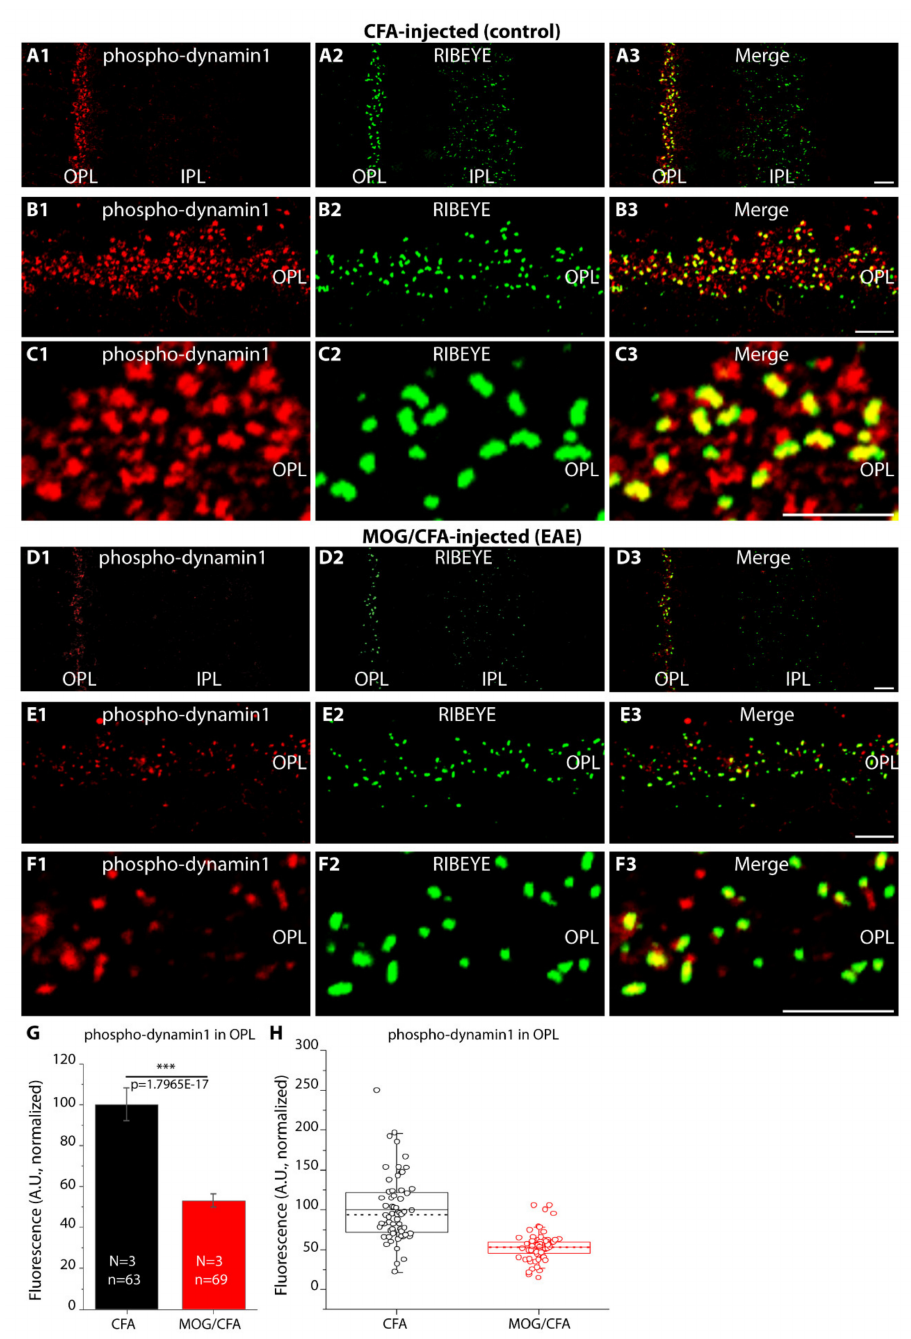
Figure 12. Phospho-dynamin1 immunosignals in photoreceptor synapses of MOG/CFA-injected early EAE mice are reduced in comparison to control mice. ( A1 – F3 ) Retina sections (0.5 µ m thickness) from CFA- and MOG/CFA-injected mice obtained on day 9 after injection were double immunolabelled with phospho-dynamin1 and RIBEYE antibody (clone 2D9), as indicated in the figure. ( C1 – C3 , F1 – F3 ) magnified views of the OPL immuno-labelled with anti-phospho-dynamin1 and anti-RIBEYE. ( G , H ) Quantification of fluorescence intensity (integrated density) of phospho-dynamin1 immunosignals in the OPL of MOG/CFA-injected and CFA-injected control mice. Values in ( G ) are means ± S.E.M. In the box-and-whiskers plots ( H ) of the data from ( G ), mean values are indicated by solid horizontal lines; median values by dotted horizontal lines. Boxes represent the 25th–75th percentiles of data points and whiskers are equal to 1.5 times of the interquartile range (IQR). Mann–Whitney U-test was applied to determine the statistical significance for fluorescence intensity in ( G , H ). ( C1 – C3 , F1 – F3 ) High magnification confocal images of the immunolabelled OPL indicate enrichment of phospho-dynamin1 at the ribbons but also expression of phospho-dynamin1 in some distance from the ribbons. Abbreviations: OPL, outer plexiform layer; IPL, inner plexiform layer; S.E.M., standard error of the mean; N, number of mice; n, number of confocal images analyzed to quantify fluorescence intensity; ***, p ≤ 0.001. Scale bars: 5 µ m ( A3 – F3